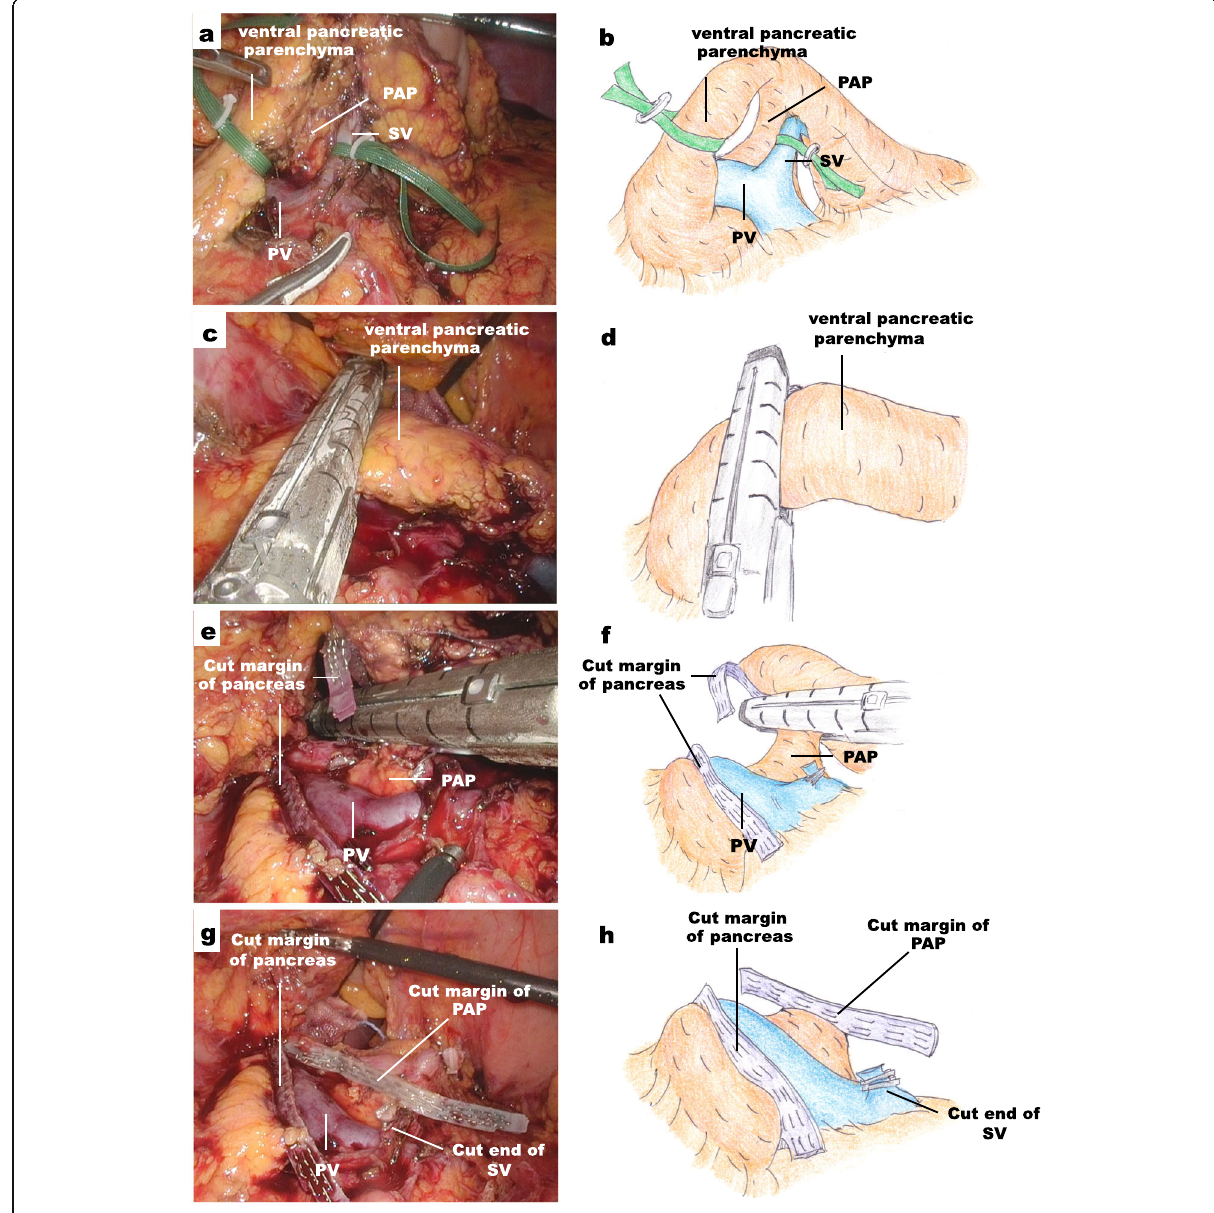
Fig. 2 Intraoperative findings. a , b Exposure of the PAP after taping the pancreatic body and SV. c , b Dividing of ventral pancreatic parenchyma using stapler after dividing the pancreatic body. e , f Dividing of PAP using the stapler. g , h Operative field after dividing the PAP. PAP, portal annular pancreas; PV, portal vein; SV, splenic